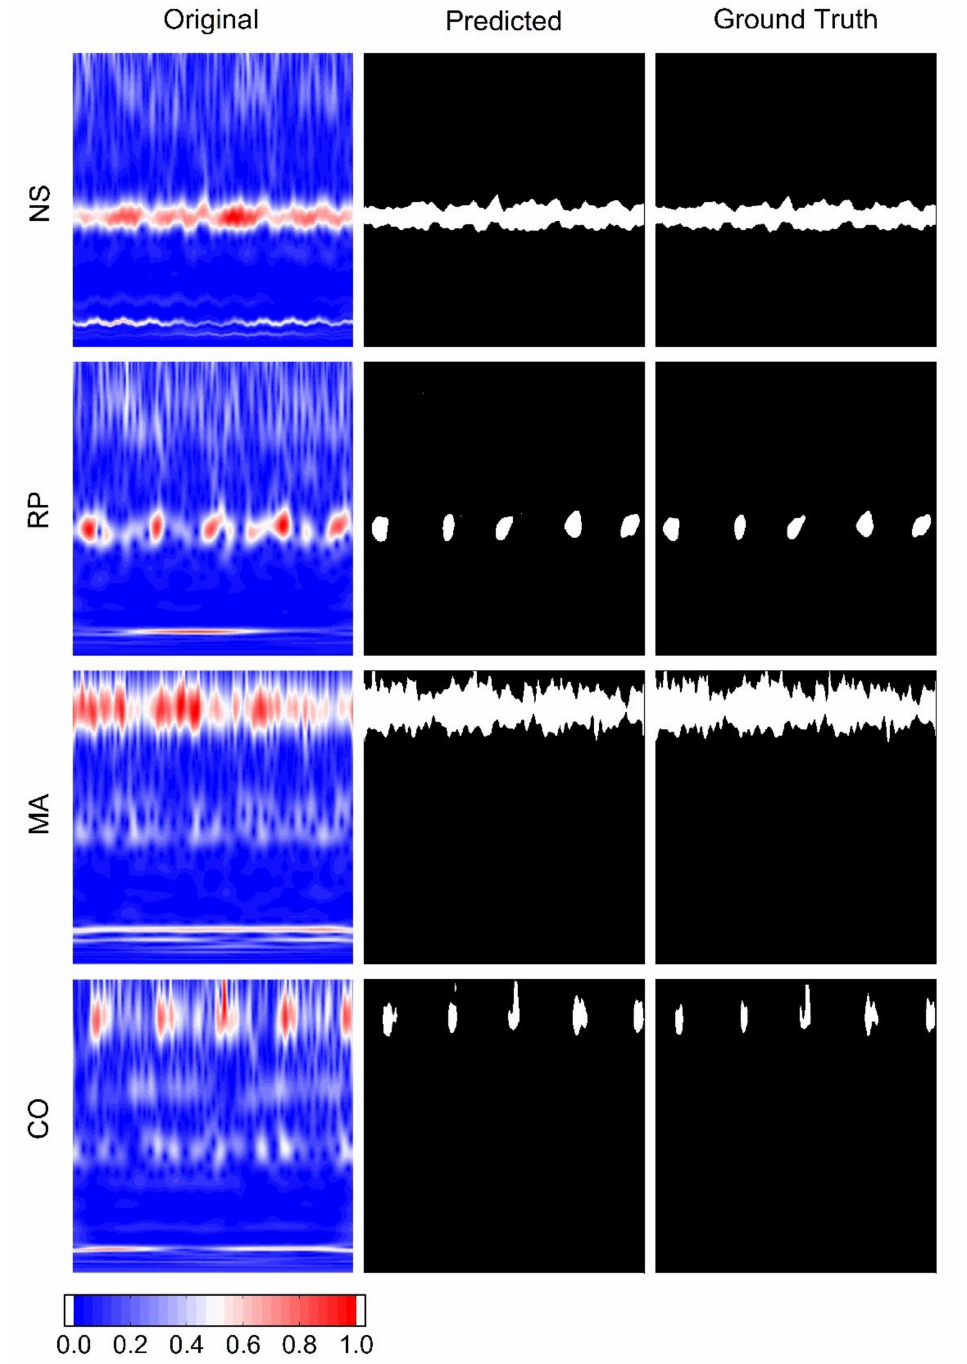
Figure 6. The results of identifying fault feature regions using U-net. White represents the character- istic area, and black represents the